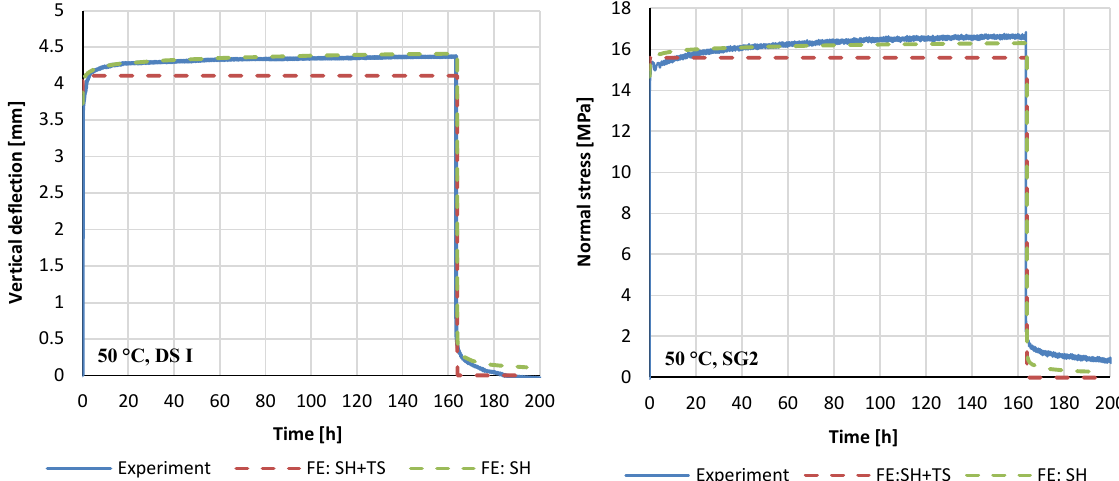
Fig. 17 Comparison of experimental and numerical midspan displacements by DS I and normal stresses by SG2 at 50